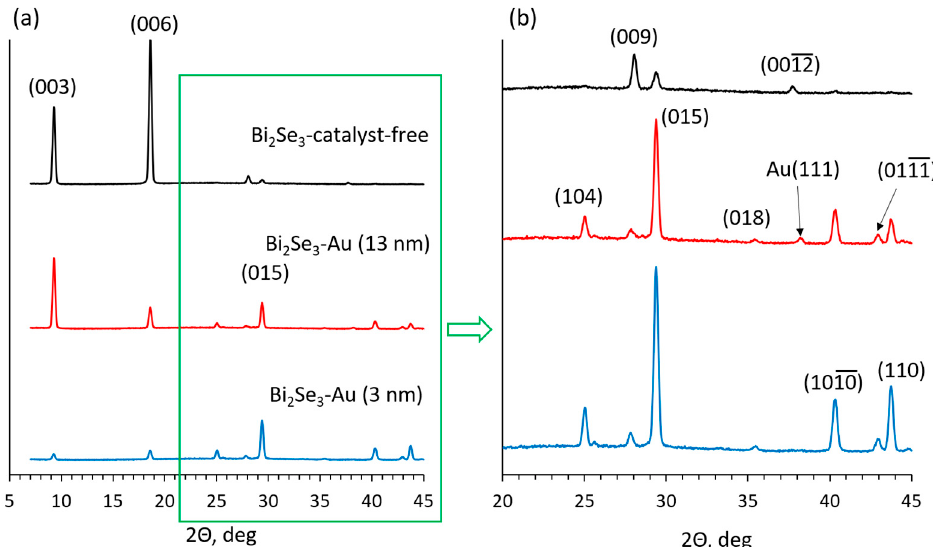
Figure 5. ( a ) XRD spectra of Bi 2 Se 3 nanostructures grown on glass by the catalyst-free method (black curve), 13 nm thick dewetted Au layer (red curve), and 3 nm thick dewetted Au layer (blue curve); ( b ) closer look at the XRD diffraction peaks corresponding to the tilted Bi 2 Se 3 nanostructures (ref. card No. 96-901-1966).